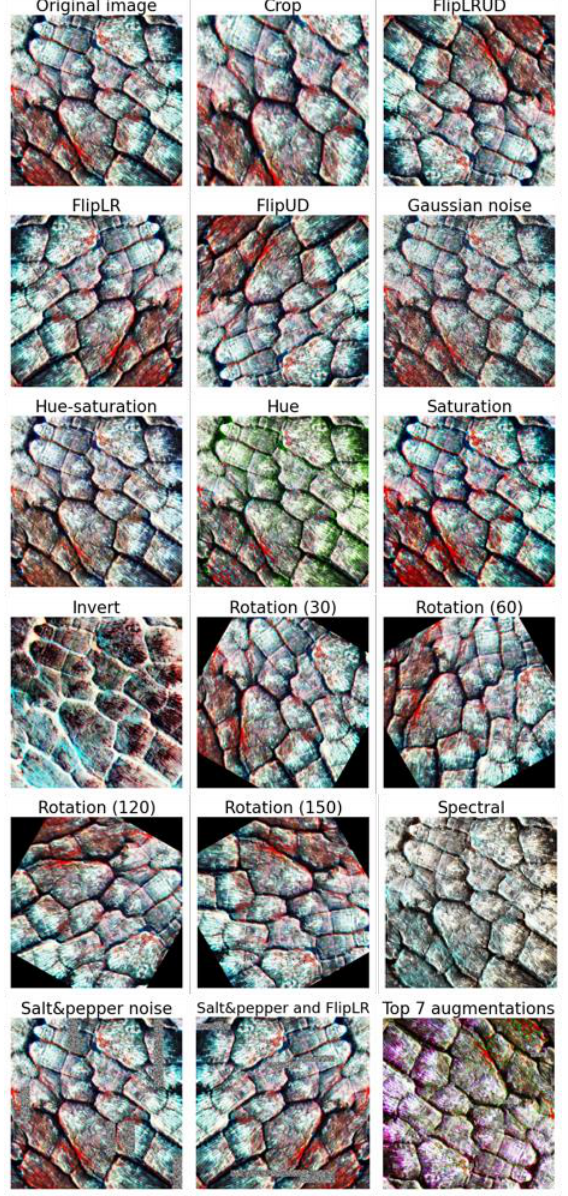
Figure 3. Augmented images compared to the original image.